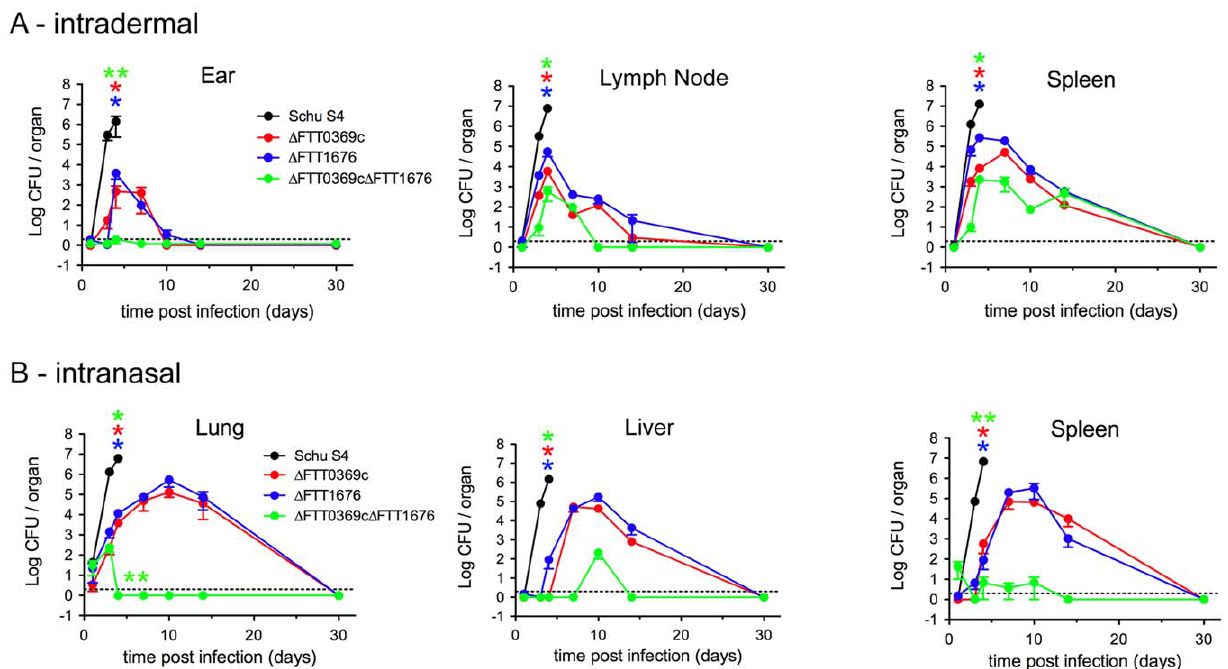
Figure 2. In vivo proliferation and dissemination of SchuS4 D FTT0369c, D FTT1676 and D FTT0369c D FTT1676 mutants following parenteral or pulmonary inoculations. Balb/c mice (n=5–10/group) were infected intradermally (A) or intranasally (B) with approximately 50 CFU or 10 CFU, respectively, of the indicated strains of F. tularensis SchuS4. Mice were regularly monitored up to 30 days after infection and euthanized at the first sign of irreversible illness. At the indicated time points, organs were harvested and assessed for bacterial burdens as described in the materials and methods. Error bars represent SEM. Data is representative of two experiments of similar design. * indicates a p value , 0.05 compared to SchuS4. ** indicates a p value , 0.05 compared to all other groups. Asterisks colors refer to the strain tested for statistically significant difference.